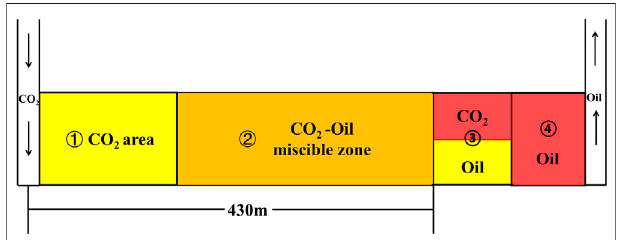
FIGURE 13 | Phase distribution between injection and production wells in unstable fl ow.